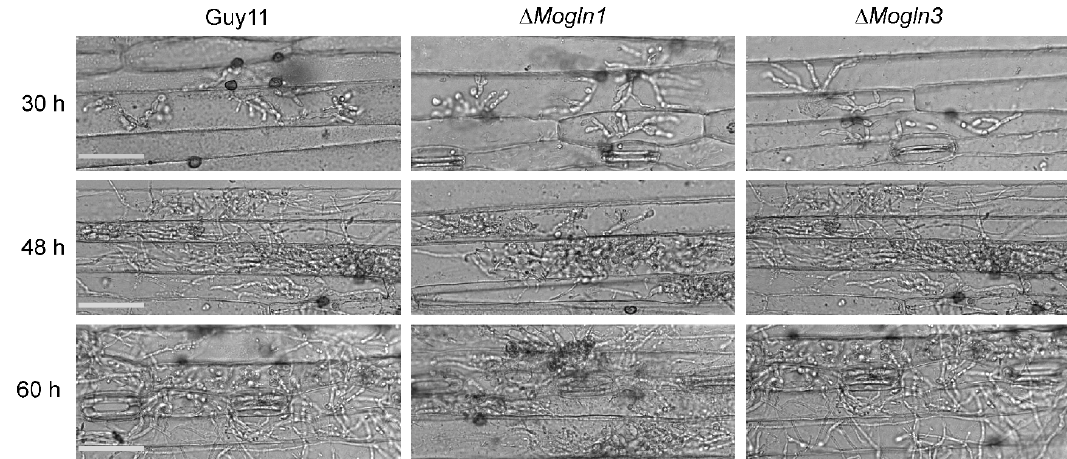
Figure 9. Bright field micrographs showing the development of invasive hyphal growth of WT, Δ Mogln1 , and Δ Mogln3 . Spore suspensions from Guy11, Δ Mogln1 , and Δ Mogln3 strains were inoculated on 10-day-old barley leaves, and invasive hyphal growth was observed at 30 h, 48 h, and 72 h. Bar= 20 μ m